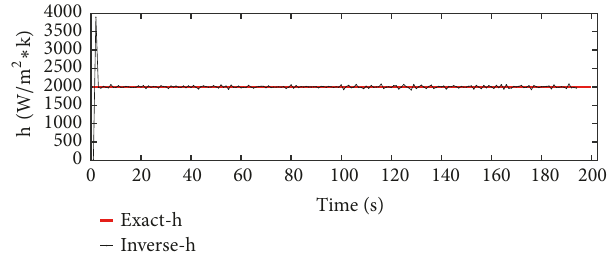
Figure 10: The heat transfer coefficient of the measuring point with 𝜎 = 0.001 .